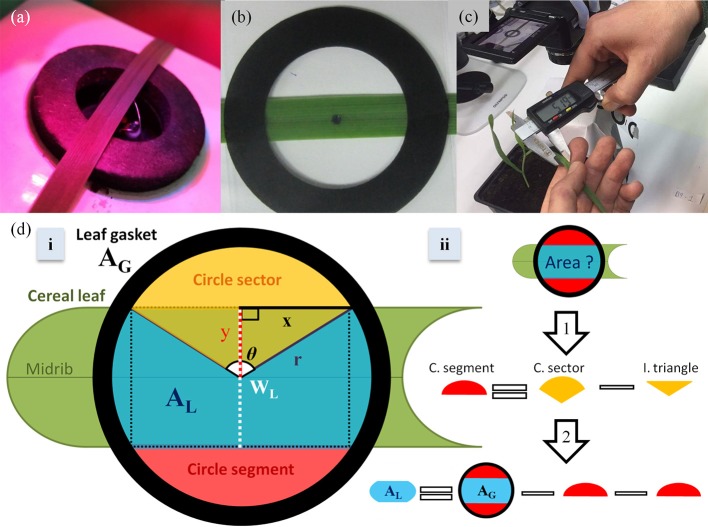
A wheat leaf smaller than the leaf gasket internal area (a); The impression of the leaf chamber used to image and quantify measured leaf area (iAL; b); measurement of leaf width in wheat plants using an electronic caliper (c); a scheme of the concept based on which the equation for calculating measured leaf area (wAL) based on leaf width (WL) was built (d). Under the assumption that the empty space created by the enclosure of a cereal leaf with leaf width (WL) smaller than the internal gasket diameter (2r) in the middle of the chamber is creating two equal circle segments (ii), the wAL will be equal to the internal gasket area (AG) minus the two empty circle segments (ii). Considering that AG is known and that the circle segment is a part of a circle sector that is comprised of a circle segment and an isosceles triangle (i), the circle segment area can then be calculated by the subtraction of the isosceles triangle from the circle sector (ii: arrow 1). The circle sector area and the isosceles triangle area can be calculated based on known dimensions (y = WL/2, r and x) and the angle θ (i).